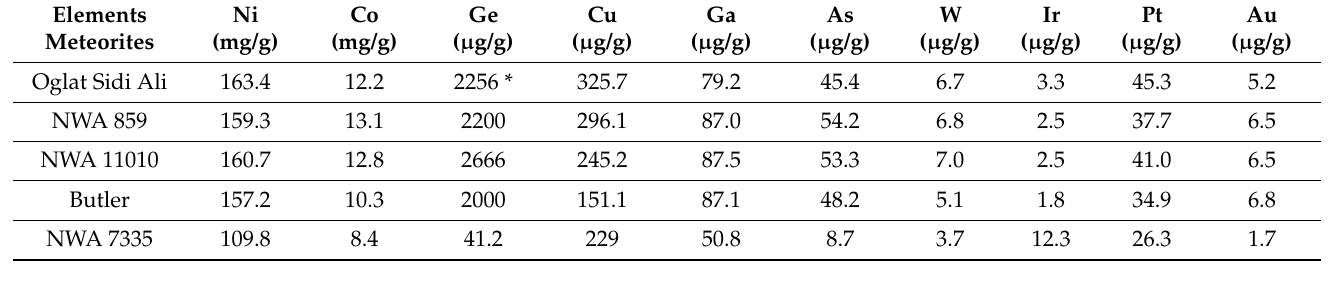
Table 4. Siderophile elements composition of the Oglat Sidi Ali, NWA 859, NWA 11010, NWA 7335 and Butler meteorites (data from Goldstein [21], Buchwald [22], Wasson [20], Moggi et al. [18], Bouvier et al. [19] and Ruzicka et al. [23]). * Estimated value from PIXE analysis.